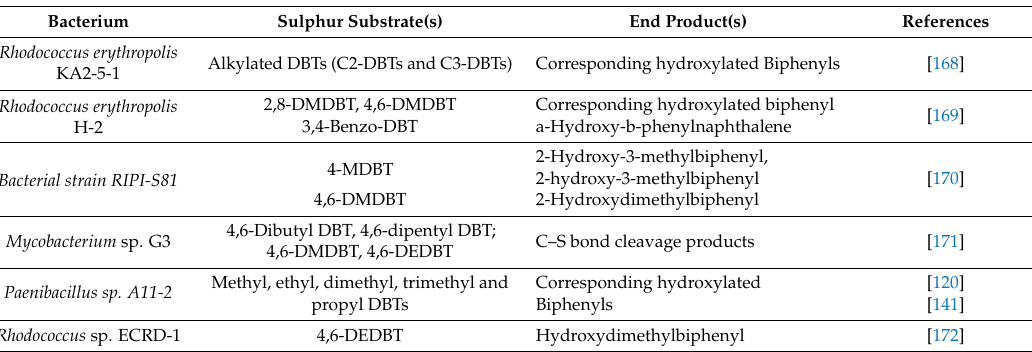
Table 4. Alkylated DBTs (Cx-DBT) desulfurization by some bacterial strains and their end products.